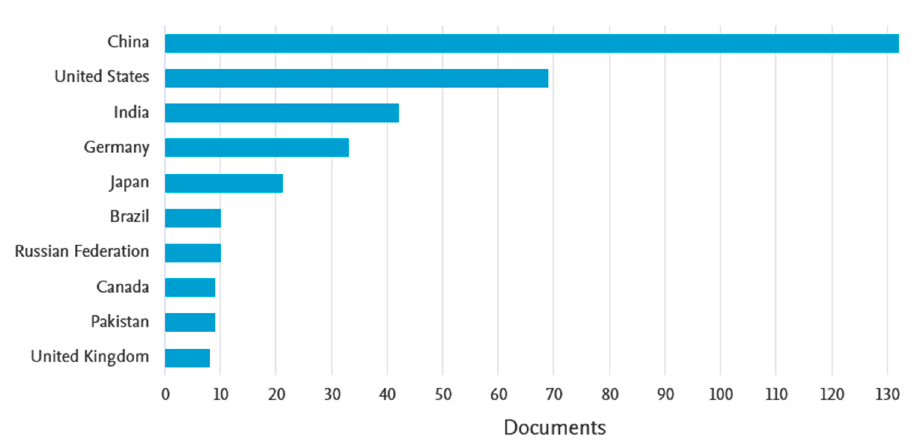
Figure 7. Distribution by region/country among published articles.